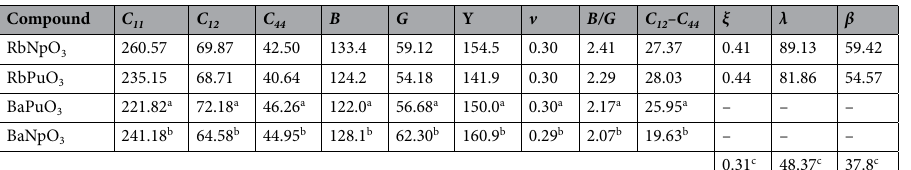
Table 4. Calculated elastic constants C 11 , C 12 , and C 44 (GPa); bulk modulus B (GPa); shear modulus G (GPa) Young’s modulus Y (GPa); Poisson’s ratio ν; B/G ratio; Cauchy’s pressure ( C 12 and Lame’s constants ( (cid:31) , β) for RbMO 3 compounds. [a] 25 , [b] 24 , [c] 73 . The results of other perovskites 24,25,73 are tabulated for